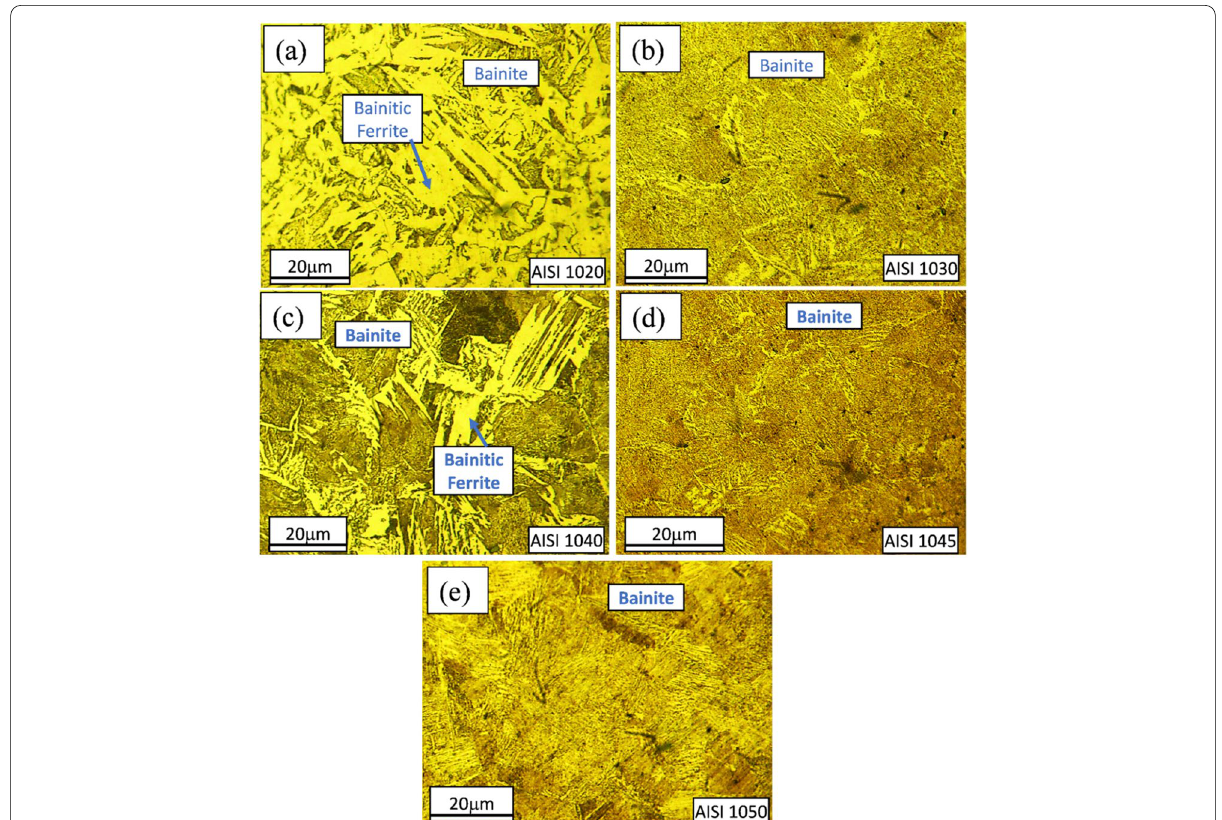
Fig. 5 Light optical micrographs showing lower-bainitic microstructures of AISI a 1020, b 1030, c 1040, d 1045 and e 1050 plain carbon steels showing bainitic microstructure as obtained after austempering